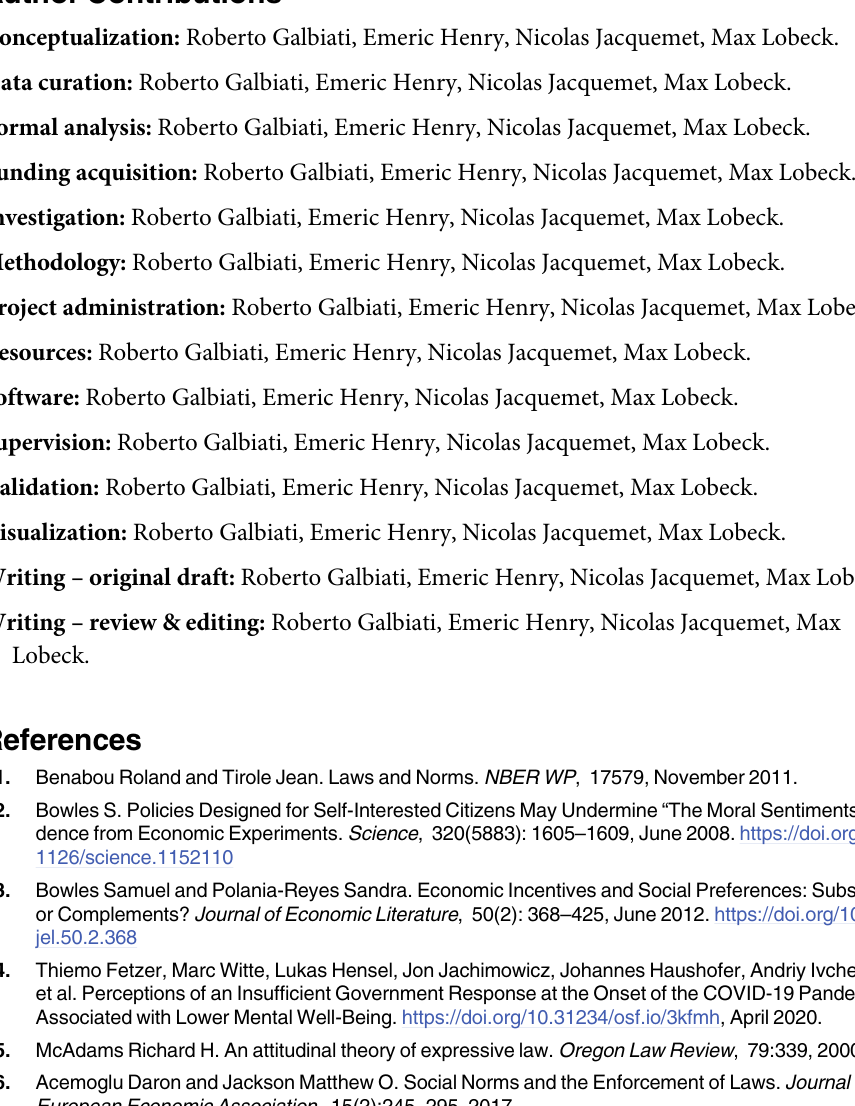
S8 Table. Heterogeneity of the DiD estimate according to individual covariates. (PDF) S9 Table. Heterogeneity of the DiD estimate according to subjective perception variables.